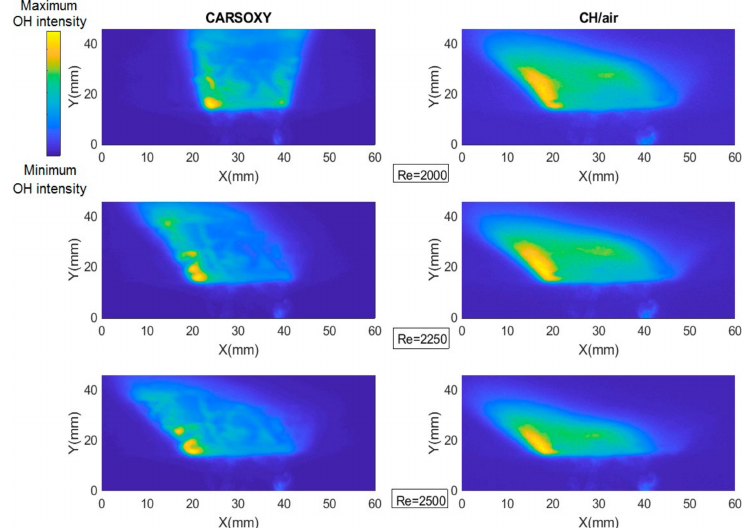
Figure A1. Chemiluminescence sample images at A: working fluid Re = [ 2000 − 2500 ] at . V CH4 = 1